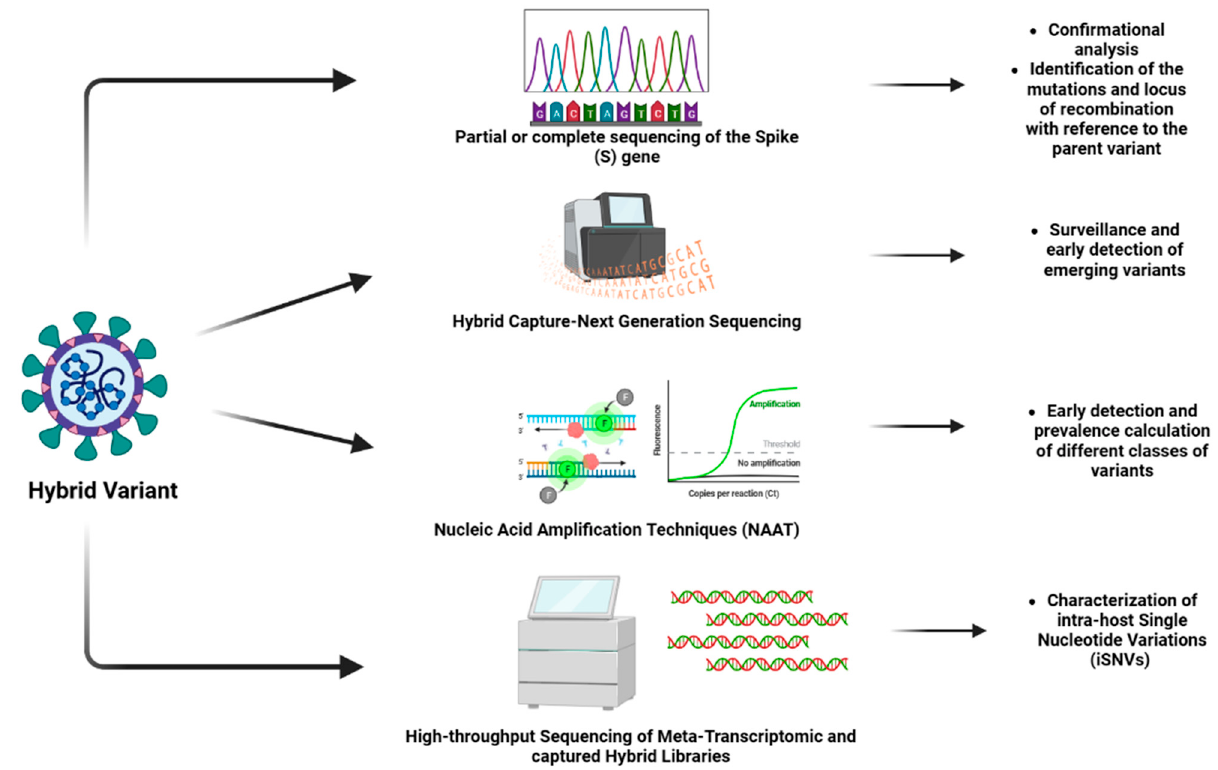
Figure 1. Different techniques for the identification of hybrid variants (Created by BioRen- der.com) .